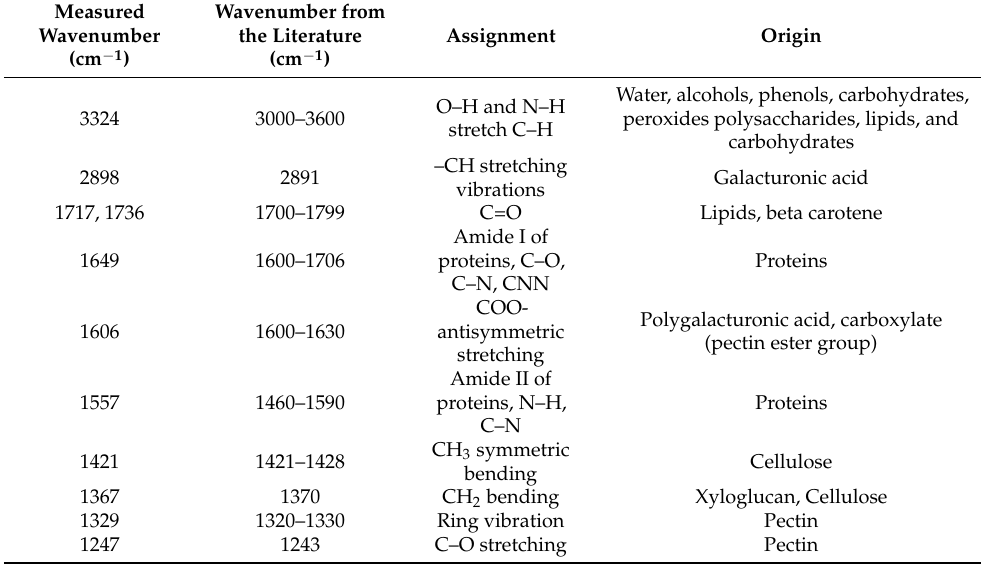
Table 4. Comparison of FT-IR absorption bands with previous results reported in the literature